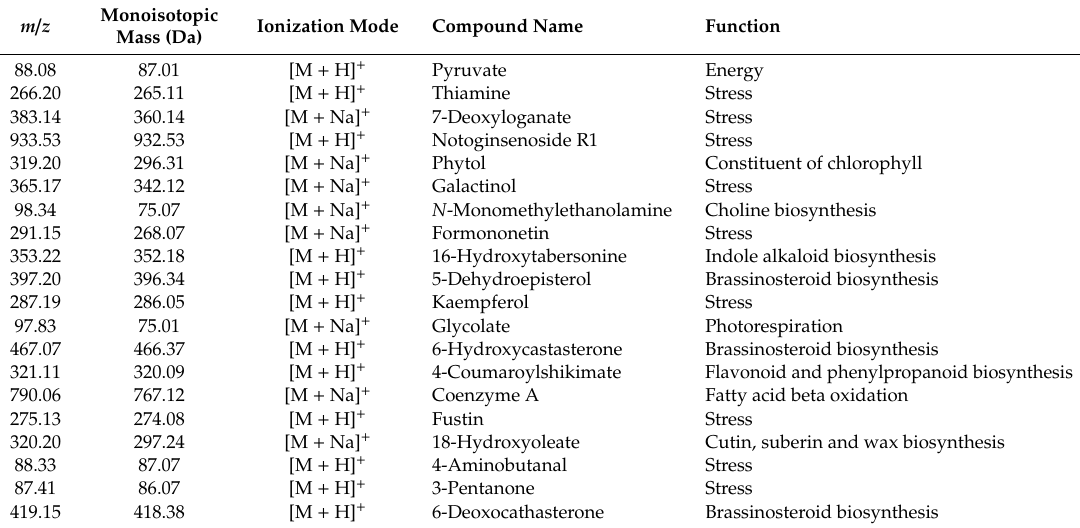
Table 2. The most important compounds detected by DLI-ESI-MS in Medicago truncatula seedlings and putatively identified by the SpiderMass software that could di ff erentiate between samples exposed to volatiles from L264, UMCV2 strains, and